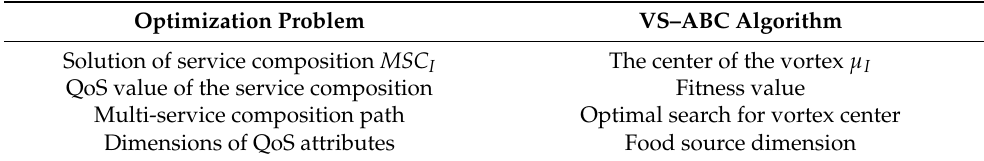
Table 16. Mapping relationship between VS–ABC and optimization